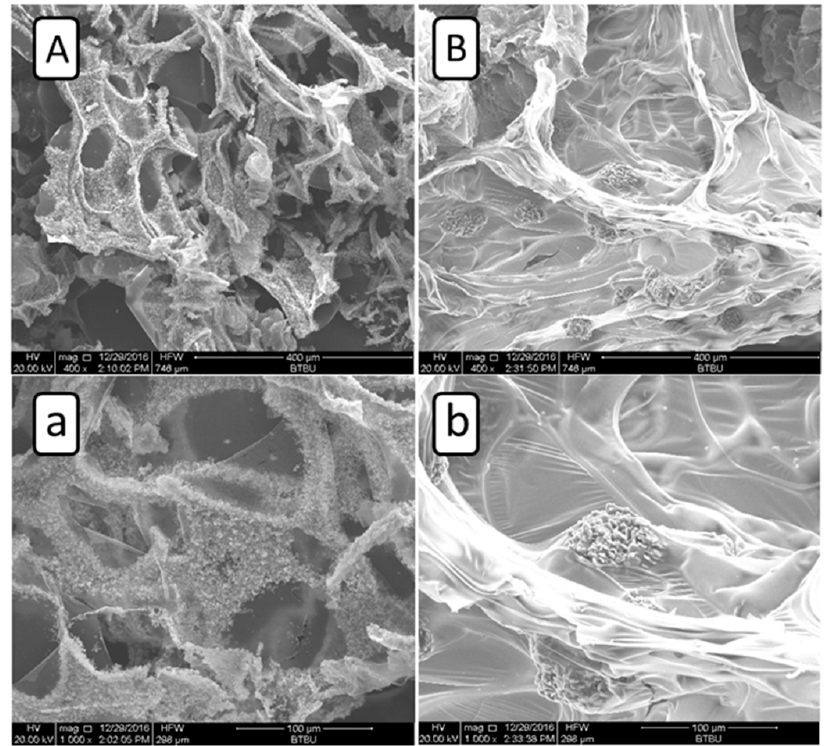
Figure 4. SEM photos of residues after the cone calorimeter test. ( A ) 400 × , 14ATH/14B/6E/PU; ( a ) 1000 × , 14ATH/14B/6E/PU; ( B ) 400 × , 14AO/14B/6E/PU; ( b ) 1000 × , 14AO/14B/6E/PU. Table 3. Elemental contents of residues from flame retardant RPUFs.